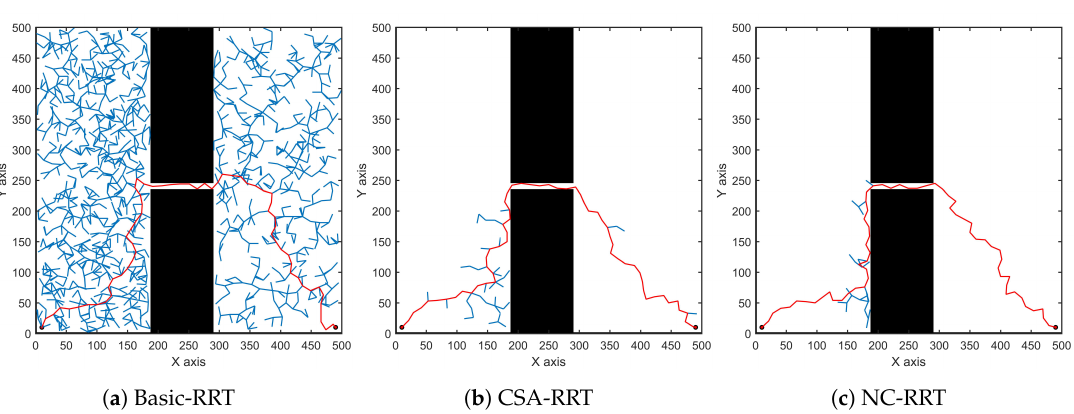
Figure 7. Performance of the three algorithms in the narrow environment. ( k = 1, c = 2 )